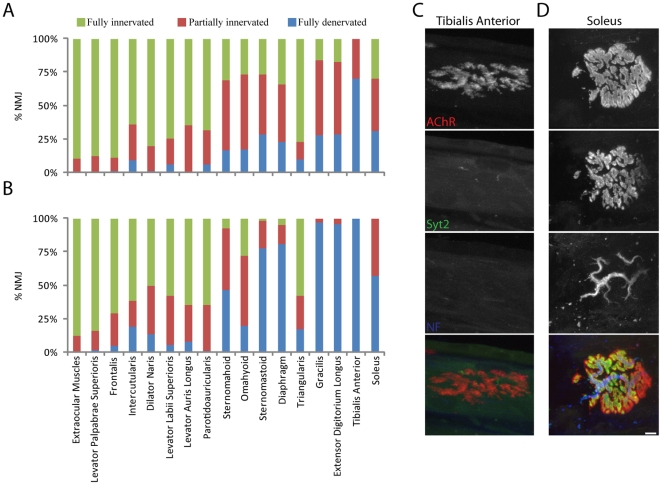
Extent of denervation in muscles from SOD-G93A mice.A, B) NMJs in muscles from symptomatic (A) or end-stage (B) SOD-G93A mice listed were scored as fully innervated, partially denervated or fully denervated. Values are shown for 14–16 weeks old symptomatic (A) and 19 weeks old end-stage mice (B). C) NMJs from soleus and tibialis anterior muscles of end stage mice, stained as in Fig. 9. Scale bar = 10 µm. Some NMJs remain partially innervated in soleus, but most NMJs are fully denervated with dispersed postsynaptic structures in tibialis anterior.